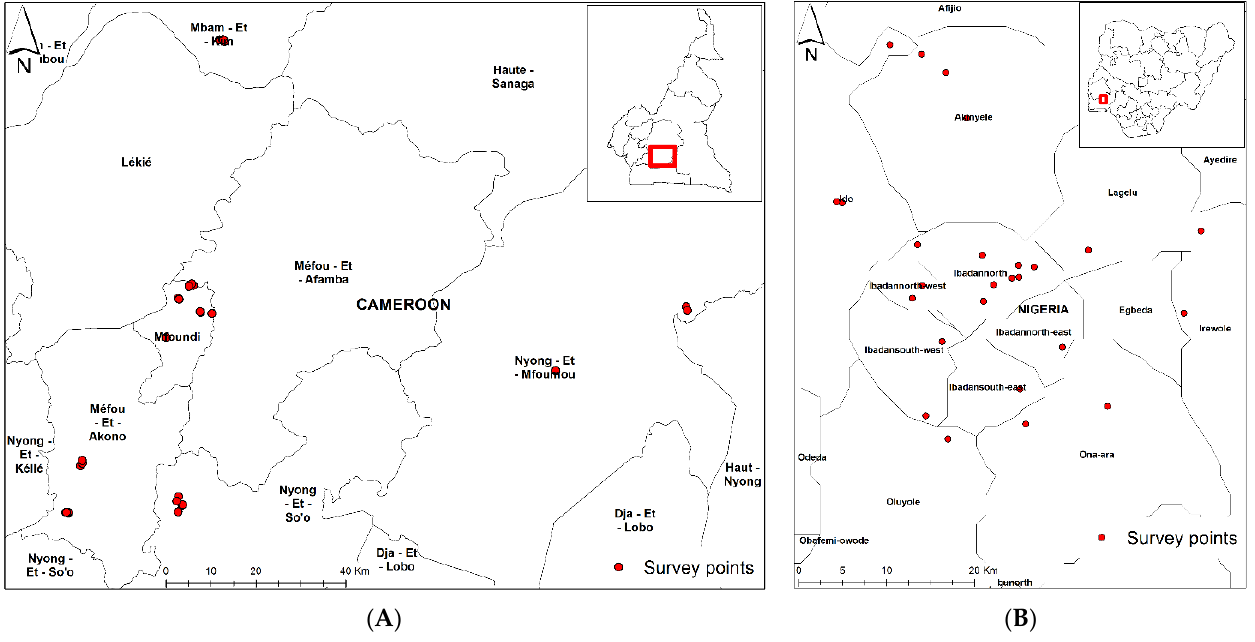
Figure 1. Sampling areas in Cameroon ( A ) and Nigeria ( B ).